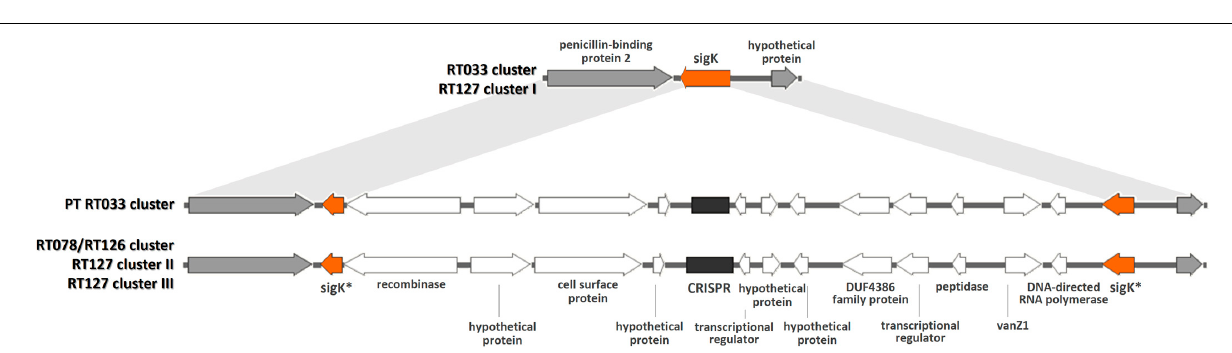
FIGURE 4 | Genetic structure of the skin Cd element of Clostridioides difficile PT RT033 clone. For all clade 5 ST11 clusters, ORFs orientation is depicted by arrows. Intact or interrupted (*) sigK genes are represented by orange arrows, while homologous flanking genes are shown in gray arrows. All 12 ORFs that compose skin Cd element are represented by white arrows, and CRISPR element is depicted as a black